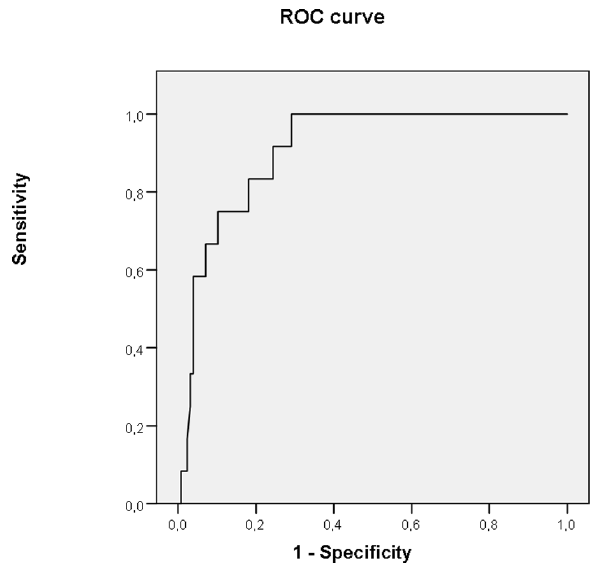
Figure 2. Receiver–operating characteristics (ROC) curve to display the relationship between sensitivity and false-positive rate (1 – specificity), and to select the best cut-off value for umbilical IL-6 for diagnosing early-onset neonatal